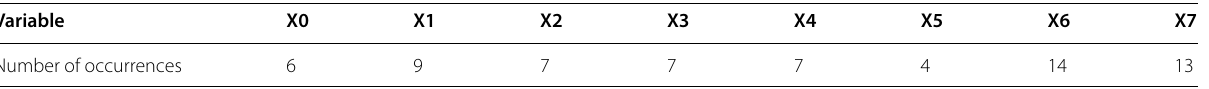
Table 7 Number of occurrences of each variable in the expressions presented in Sect. 6.5.